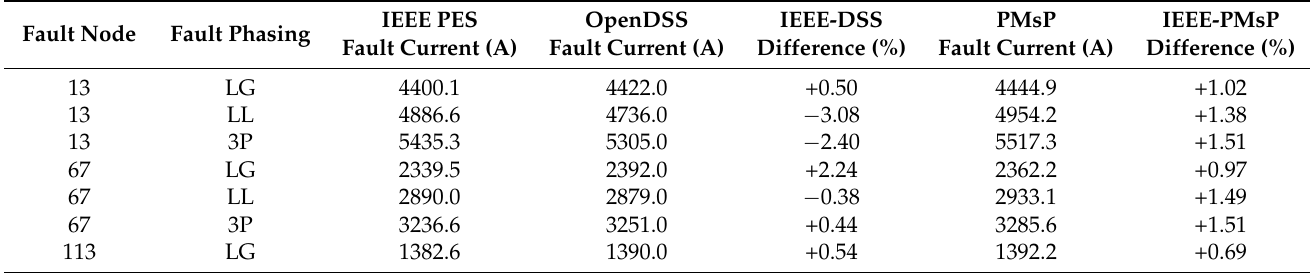
Table 1. Comparison of results for short-circuit flow formulation.